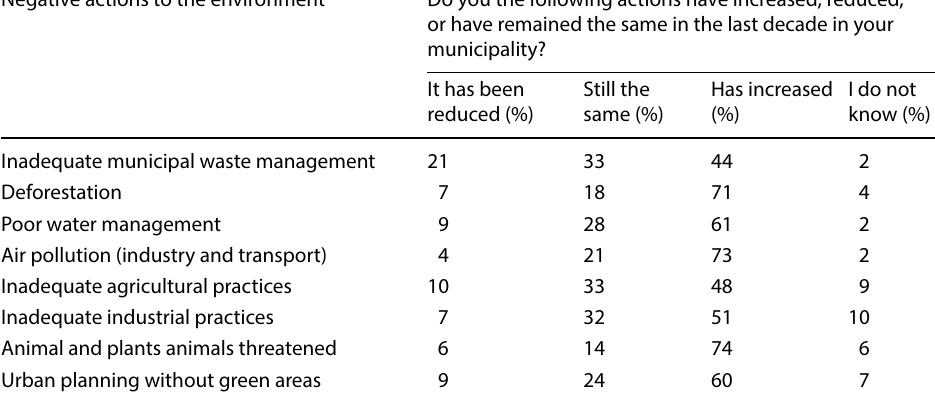
Table 10 Perception on negative actions to the environment